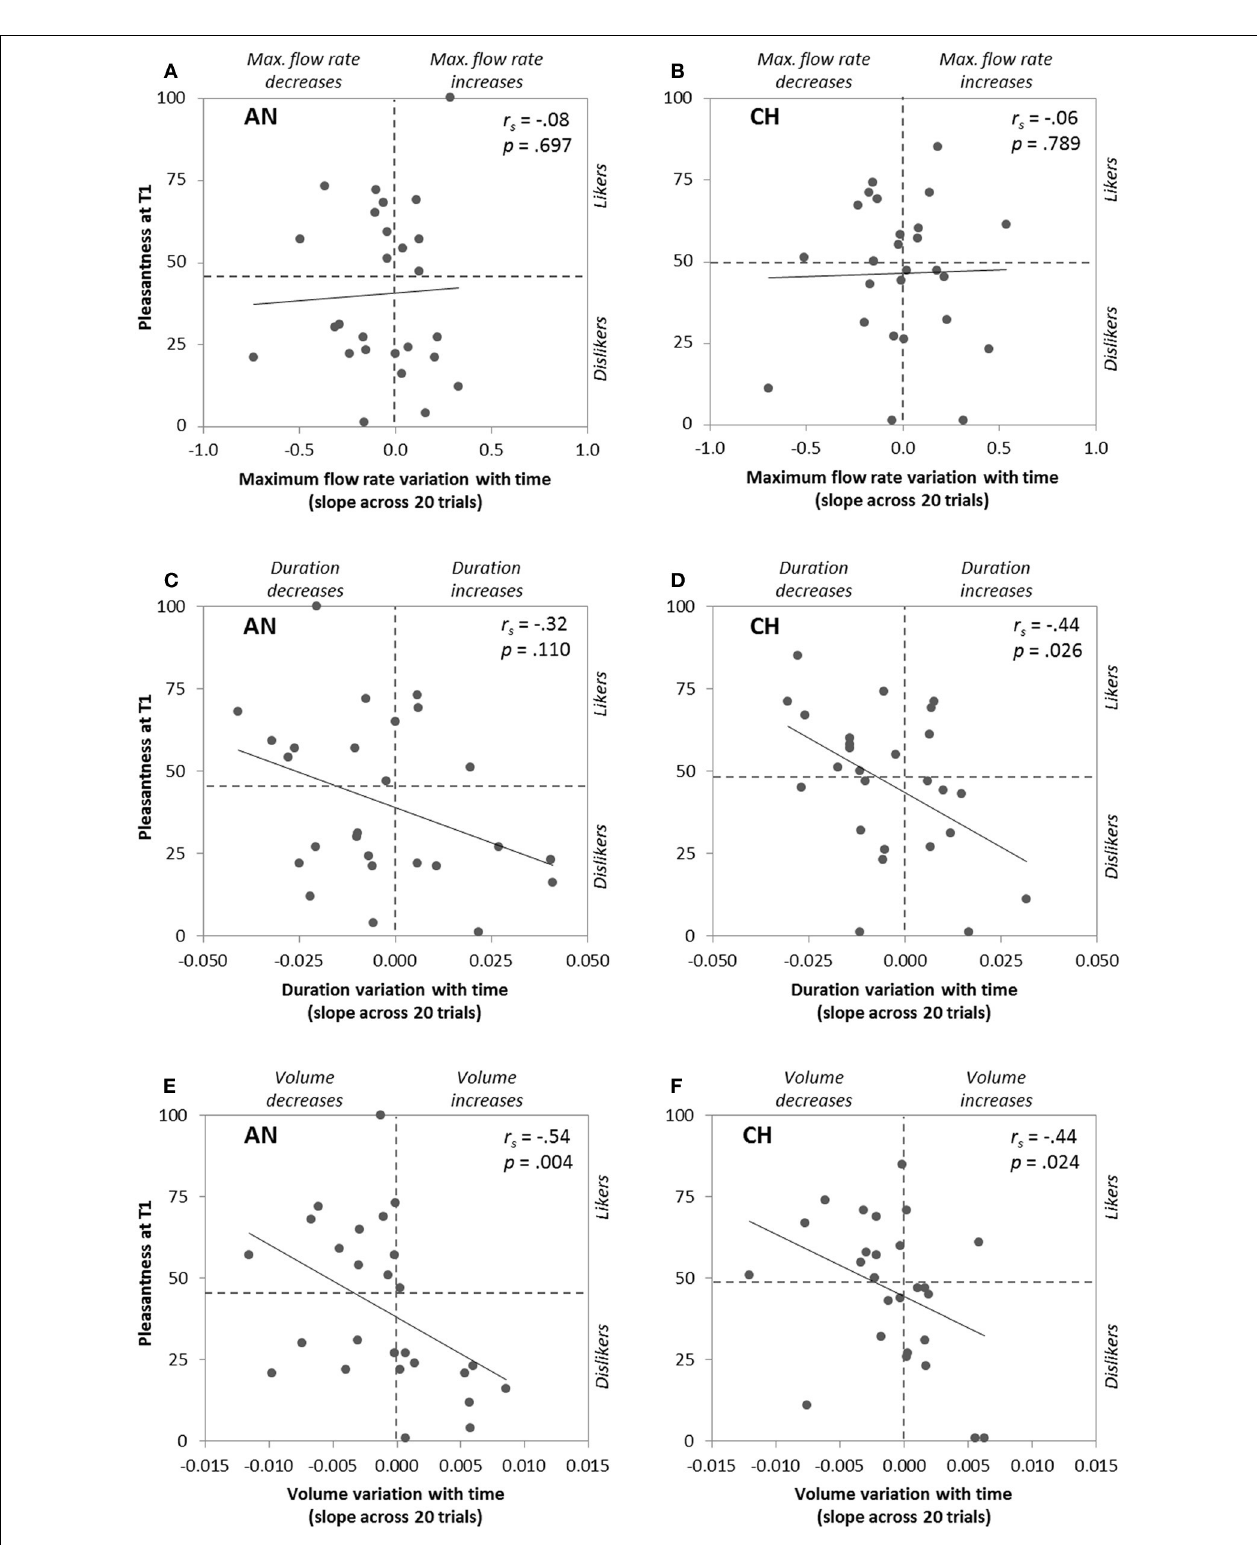
FIGURE 4 | Correlations between pleasantness ratings at T1 (first odor presentation) and time-related changes of the following sniff parameters: maximumflowrate(A,B),duration(C,D),andvolume(E,F)representedbytheirslopesacrossthe20odorpresentations,foranise(AN)andchocolate(CH).